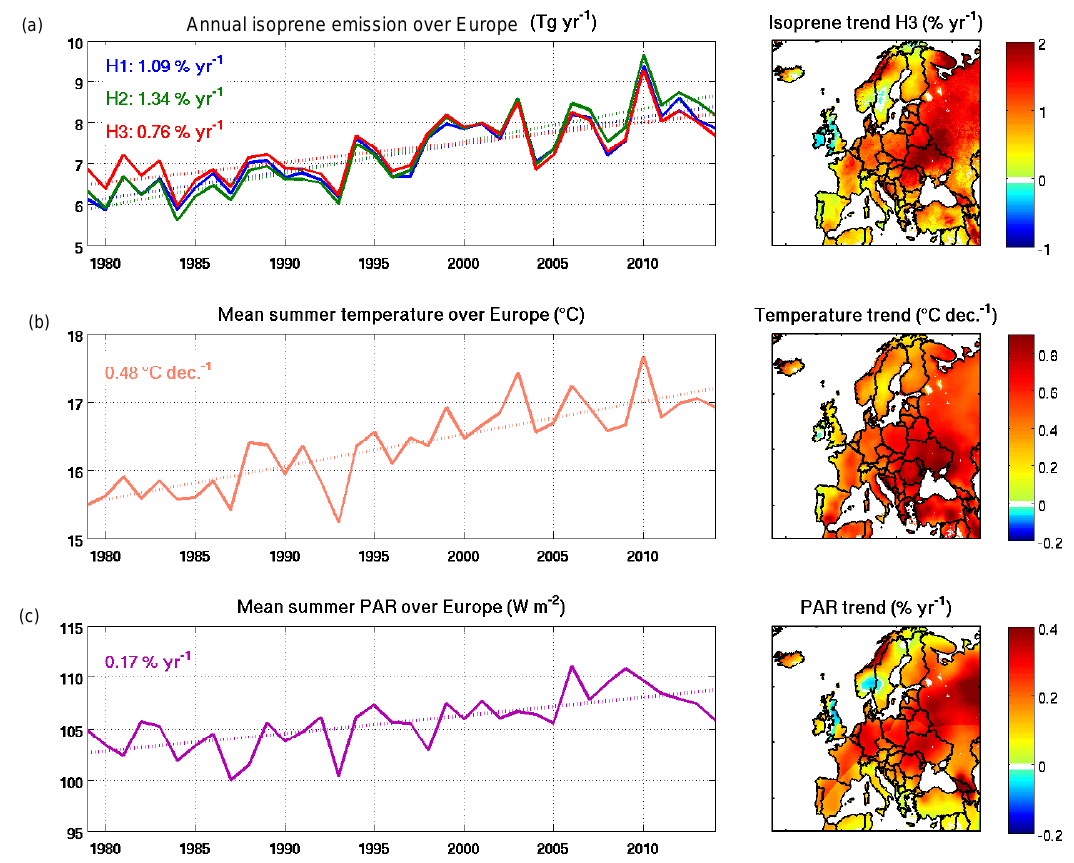
Figure 3. Annual isoprene emission and emission trends between 1979 and 2014 (in % per year) over the European domain (34–70 ◦ N, 25 ◦ W–50 ◦ E), obtained from the historical simulations (Table 1). Mean annual summer temperature and solar radiation (PAR) obtained from ERA-Interim (ECMWF) reanalyses over the same period are shown in the middle and lower panels,